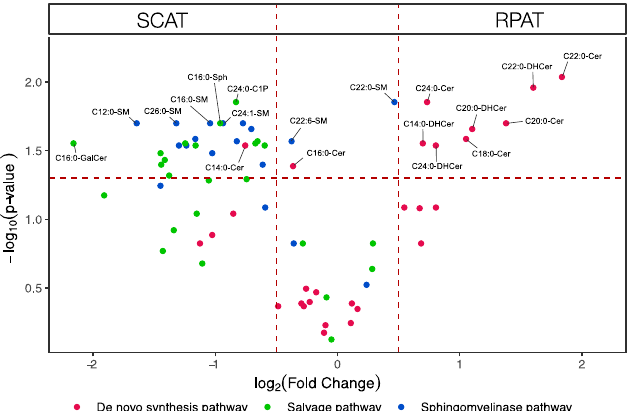
Figure 2. Volcano plot visualizing the fold change (retroperitoneal (RPAT) to subcutaneous adipose tissue (SCAT)) over the p -value of sphingolipids from six pairs of adipose tissues. The p -value of each sphingolipid species was calculated by paired Student’s t -test with false discovery rate (FDR) correction. The dotted horizontal line indicates a statistical threshold of p < 0.05, and the dotted vertical lines between − 0.5 and 0.5 log 2 (fold change) indicate the 1-fold restriction threshold. The figure shows that sphingolipid species in the de novo synthesis pathway were more concentrated in RPAT. In contrast, sphingolipid species in the salvage pathway and the sphingomyelinase pathway were more concentrated in SCAT. Cer: ceramide; C1P: ceramide-1-phosphate; DHCer: dihydroceramide; GalCer: galactosylceramide; Sph: sphingosine; SM: sphingomyelin. Metabolites 2020 , 10 , x